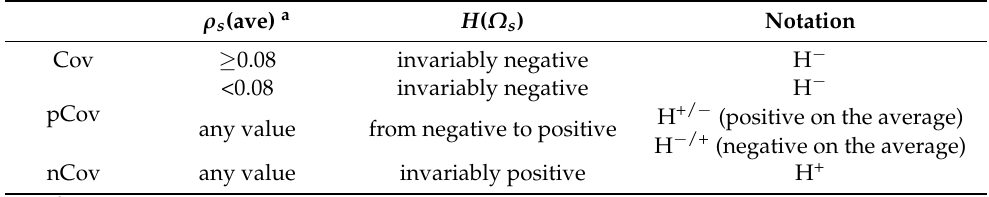
H +/ − (positive on the average) H − /+ (negative on the average)